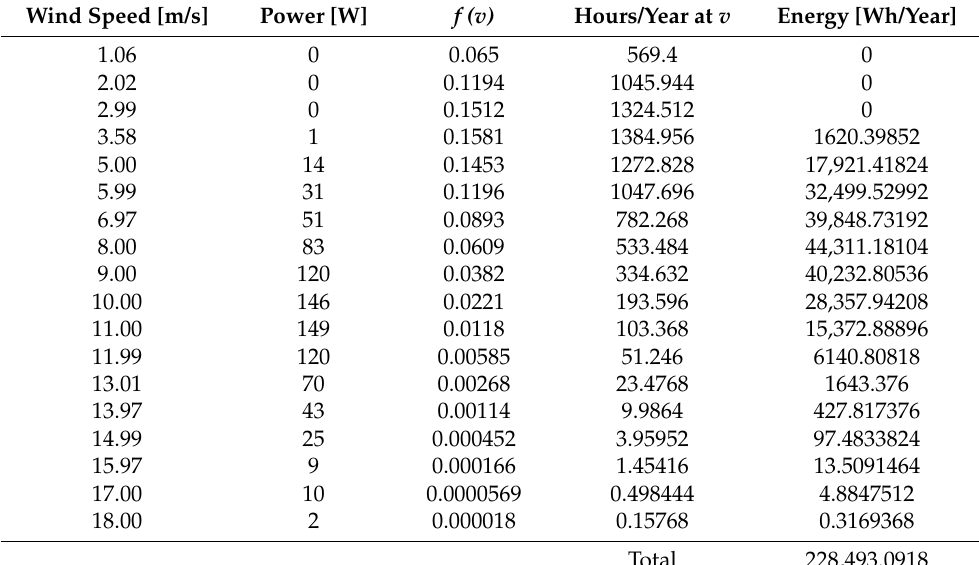
Table 2. Rayleigh probability density functions and wind turbine